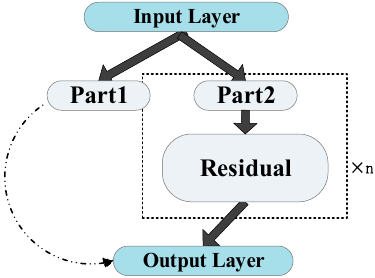
Figure 2. CSPNet structure for Resblock_body.